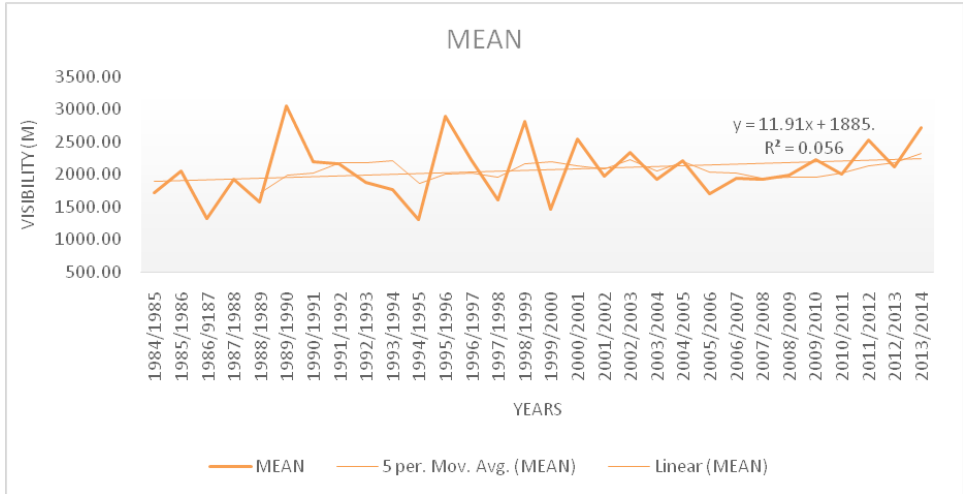
Figure 5: Seasonal mean distributions and trend of visibility for Maiduguri station